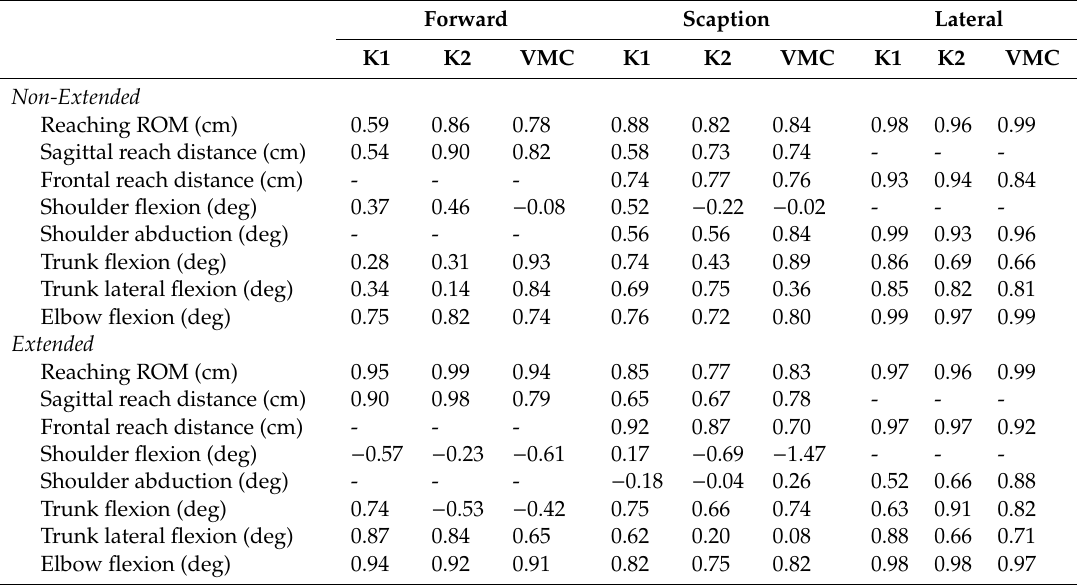
Table 3. Reliability measured by intra-class correlation coe ffi cients (ICC) between testing days D1 and D2 for each of the three